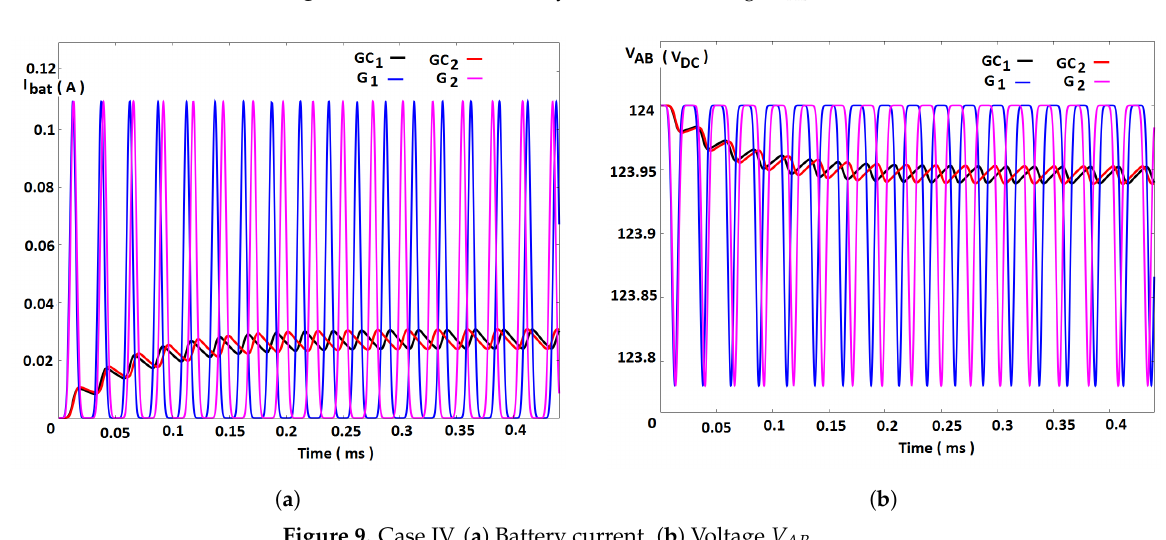
Figure 8. Case III. ( a ) Battery current. ( b ) Voltage V AB .